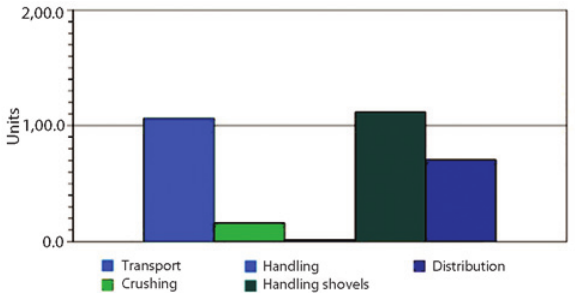
Fig. 16. Energy of individual phases for C&DW recycling/